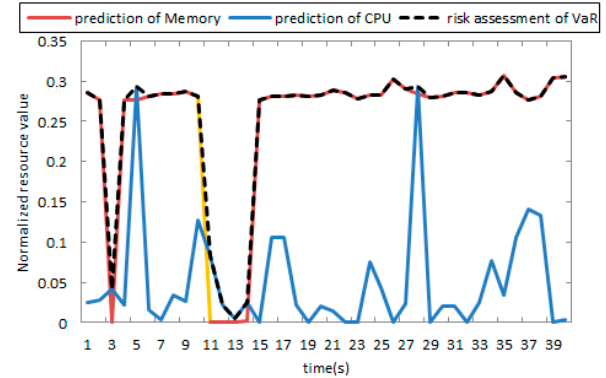
Figure 16. Prediction curve of the VaR.